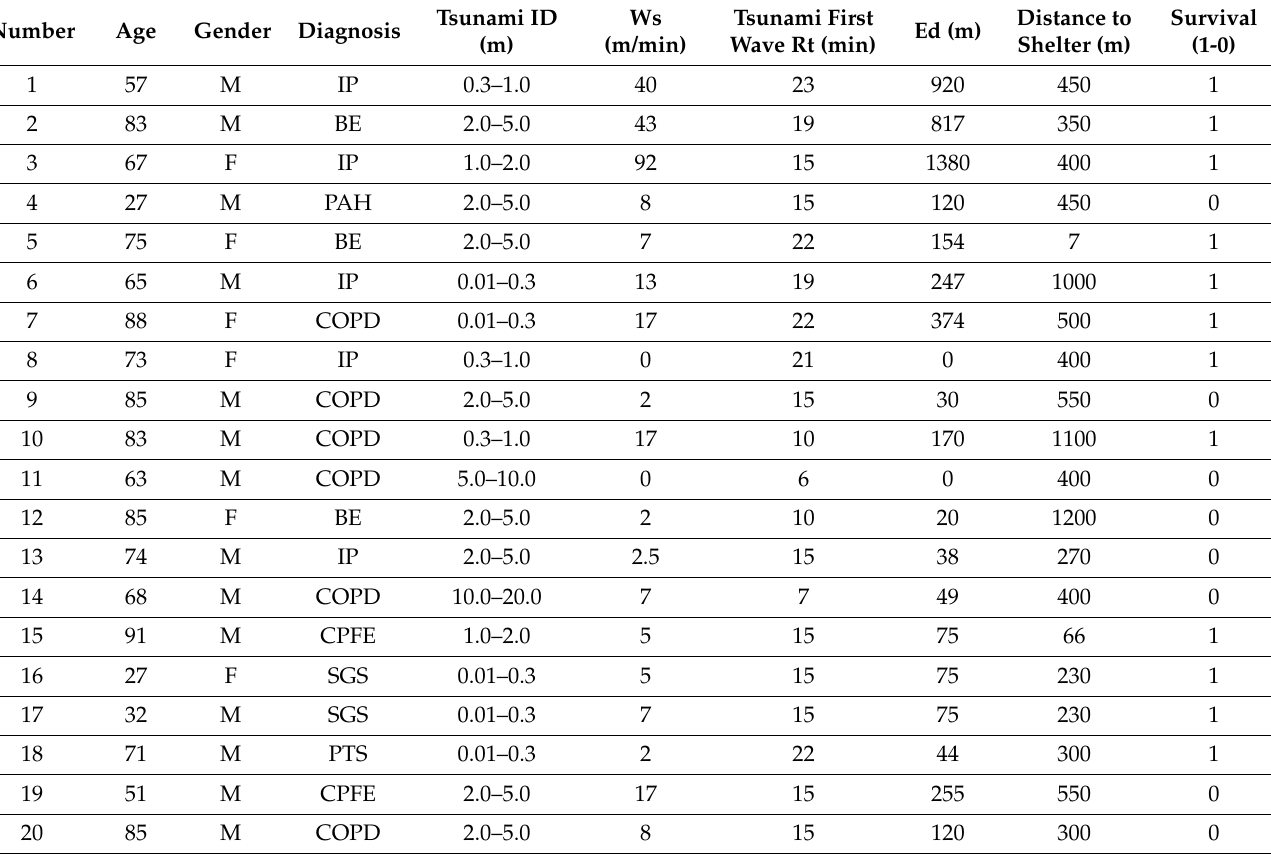
Table 2. Data on patients with chronic respiratory diseases in tsunami